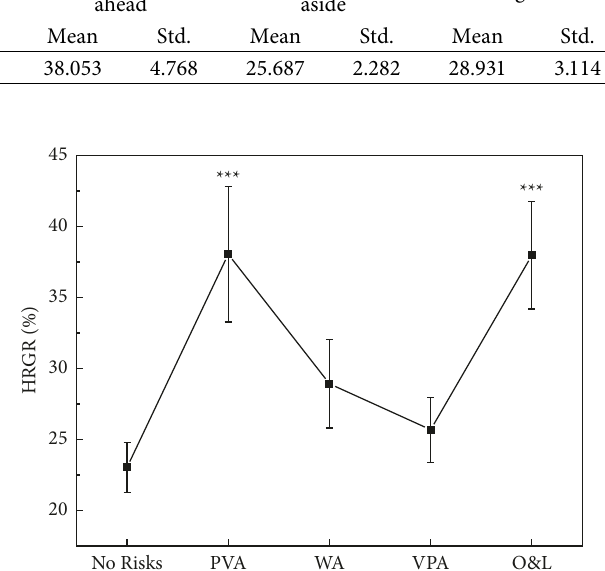
Figure 7: Comparison of heart rate growth rates of drivers at different types of random risk